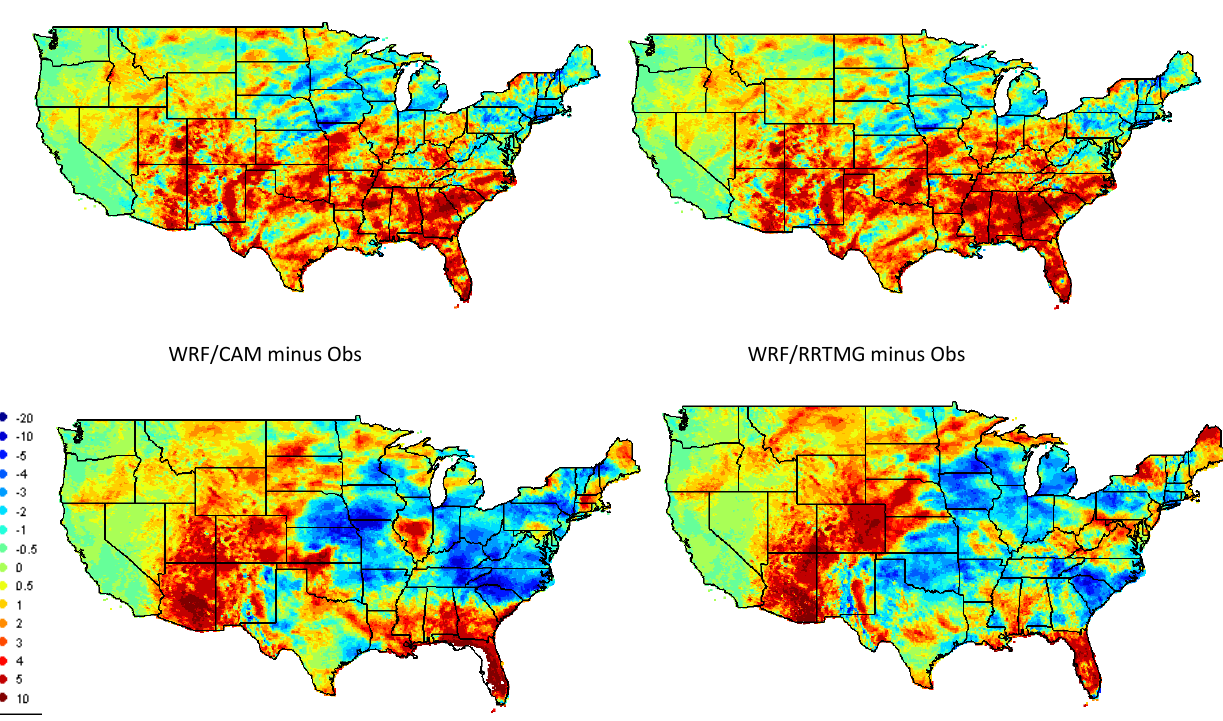
Figure 24. The difference (in/month) of monthly domain means of precipitation between the observations and model results of WRF-CMAQ/CAM, WRF-CMAQ/RRTMG, WRF-only/CAM and WRF-only/RRTMG on the basis of 12-km resolution simulation over the CONUS for August of 2006